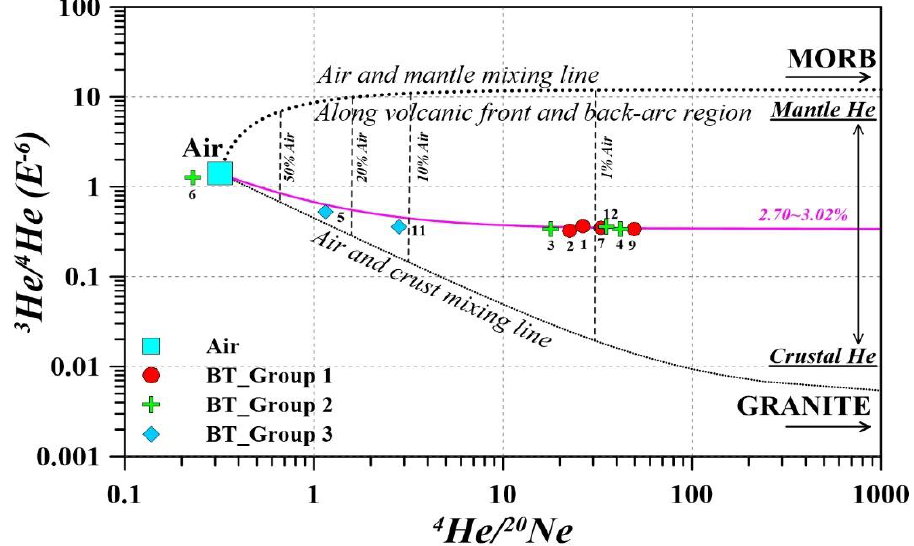
Figure 7. Plot of 3 He/ 4 He and 4 He/ 20 Ne ratios for air, crust and mantle mixing.